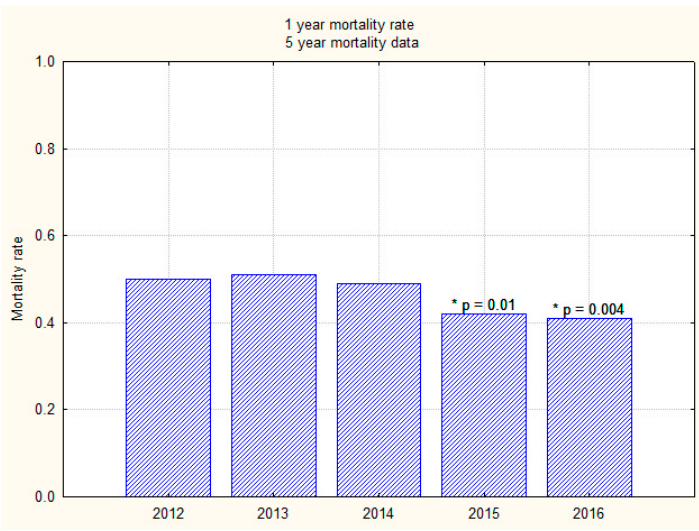
Figure 4. A bar graph showing one-year mortality trend over 5 years (2012–2016). * A significant reduction ( p < 0.01).